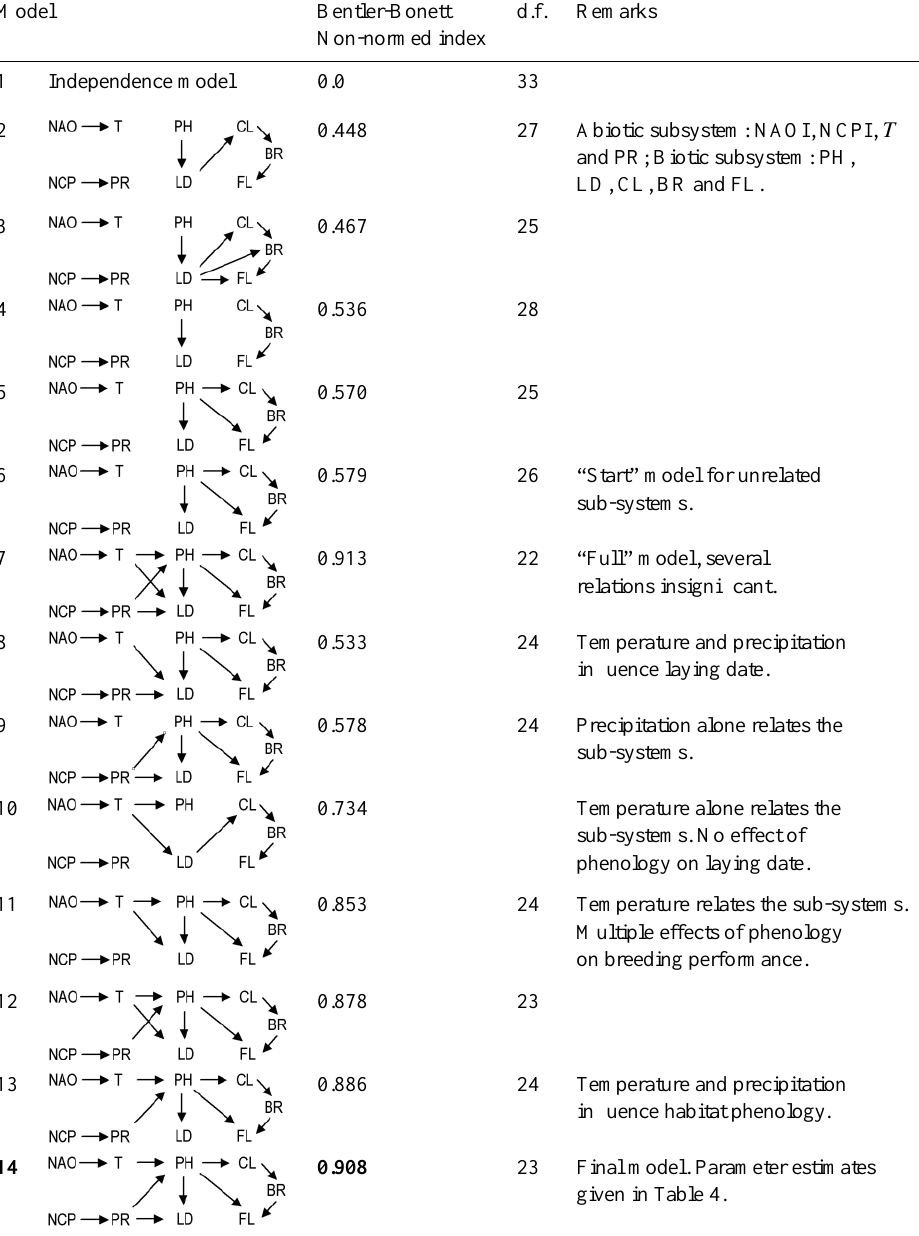
Table 3. Model selection results for structural equation models (SEM, Generalized least squares maximum likelihood estimation). First, models 2–6 evaluate the structure within the biotic (habitat-bird) sub-system, excluding climate forcing. Second, the structure of the bi- otic sub-system of model 6 was kept constant to evaluate the effects of atmospheric circulation indices (NAOI/NCPI), climate (tempera- ture/precipitation) and habitat phenology on the breeding phenology and performance. The favoured model 14 is the most parsimonious model without statistically insignificant relations. It indicates that the interface between abiotic and biotic components is via ambient tem- perature and precipitation, both acting on habitat phenology. Factor loadings of model 14 are given in Table 4, the path diagram and equa- tions in Fig. 2. NAOI = North Atlantic Oscillation index, NCPI = North Sea – Caspian Pattern index, T = temperature, PR = precipitations, PH = habitat phenology (date of beech bud burst), LD = laying date, CL = clutch size, BR = brood size, FL = number of